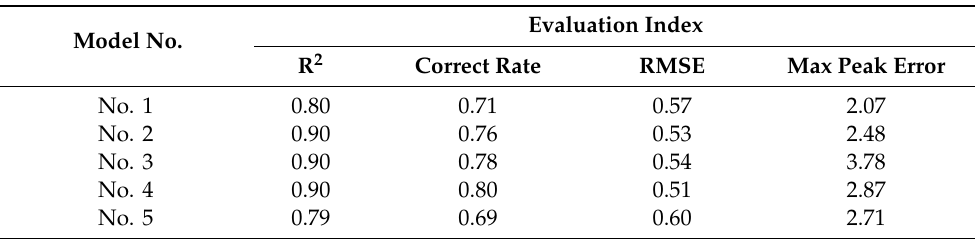
Table 9. Evaluation index value of each model (the case where one CRAC suddenly stops while both CRACs are operating).